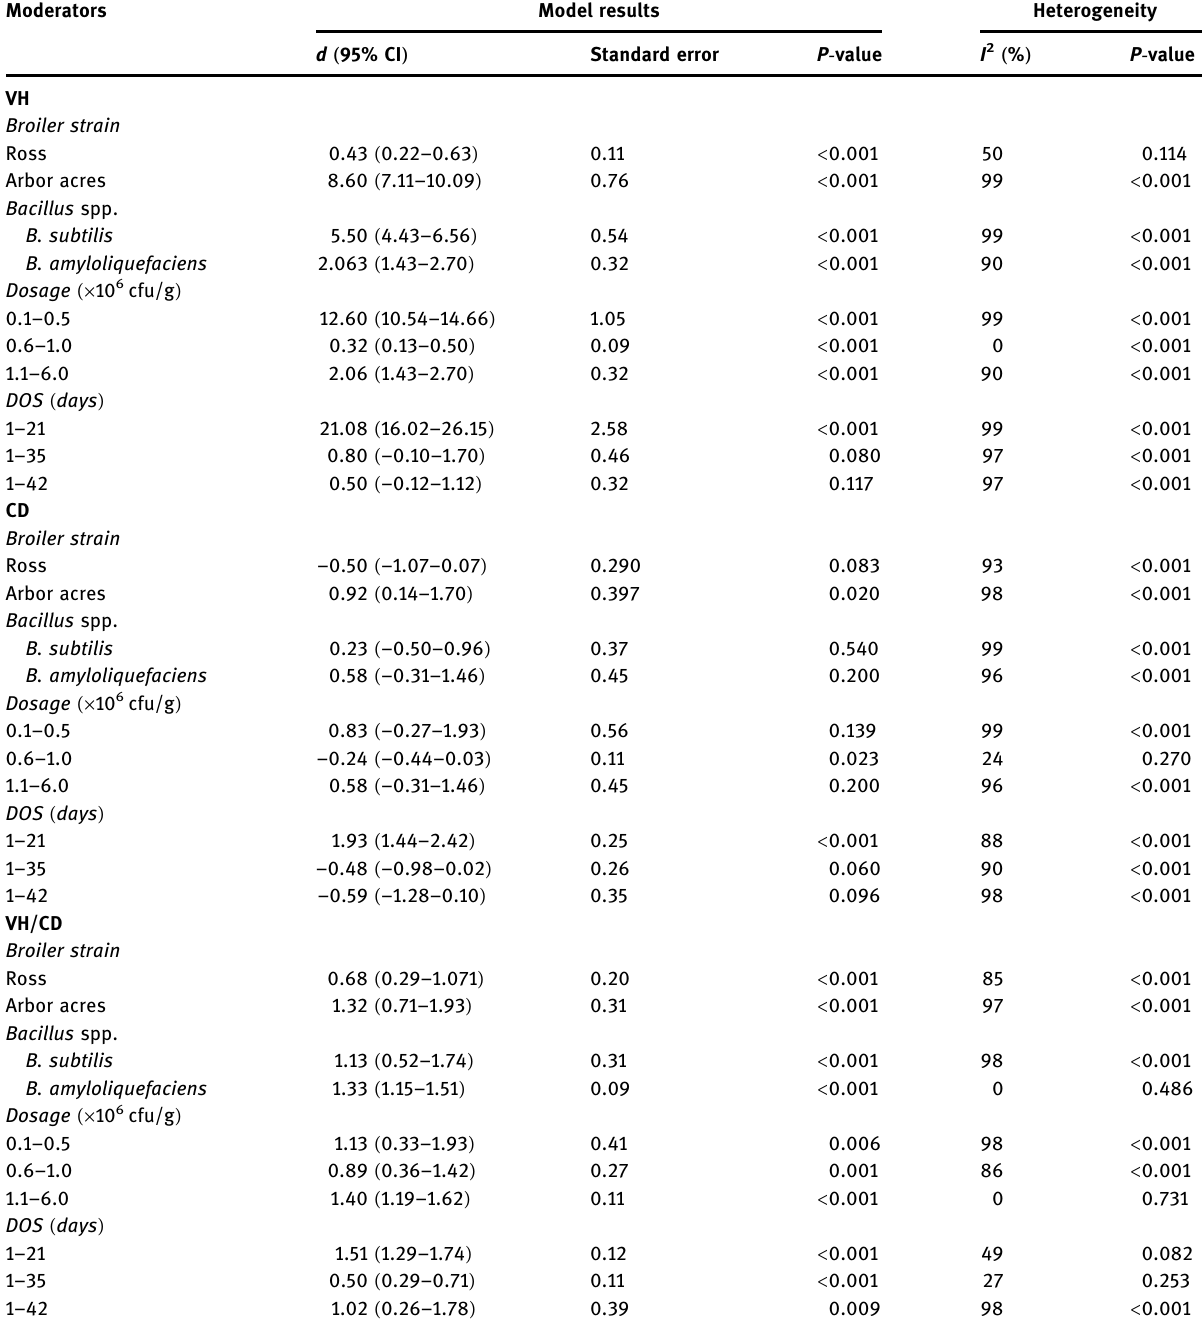
Table 6: E ff ect of modi fi ers on ileal histomorphometric variable in broilers fed Bacillus - supplemented diets